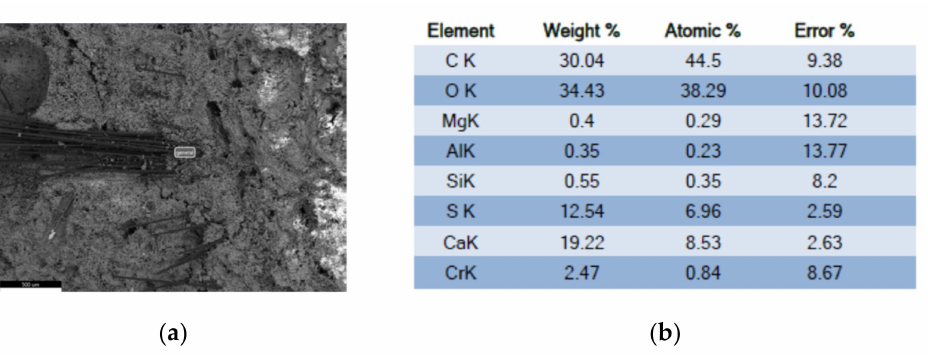
Figure 11. Analysis area and composition results ( a ) micrograph of calcium sulfate with additive; ( b ) chemical composition of the reference gypsum. (Source: the author.)